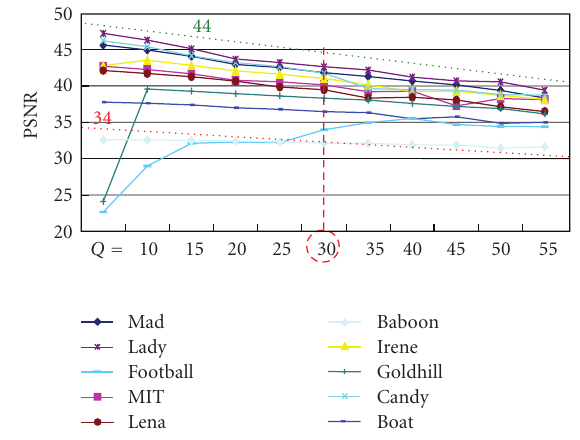
Figure 8: The quality of error-recovery image as ROI extracted in various